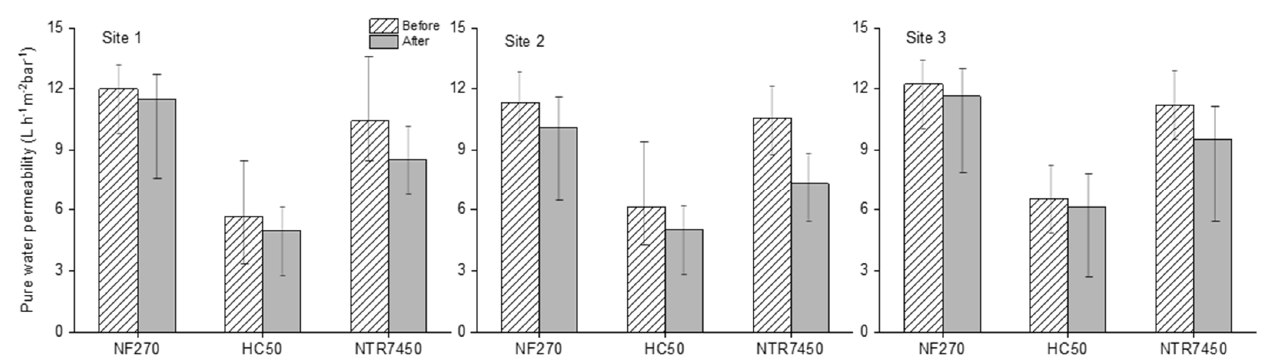
Figure 6. Pure water permeability of NF270, HC50, and NTR7450 membranes, before and after filtering MF permeates from all of the sampling sites. Pressure: 6.5 bar; stirring rate: 400 rpm; temperature: 25 °C.